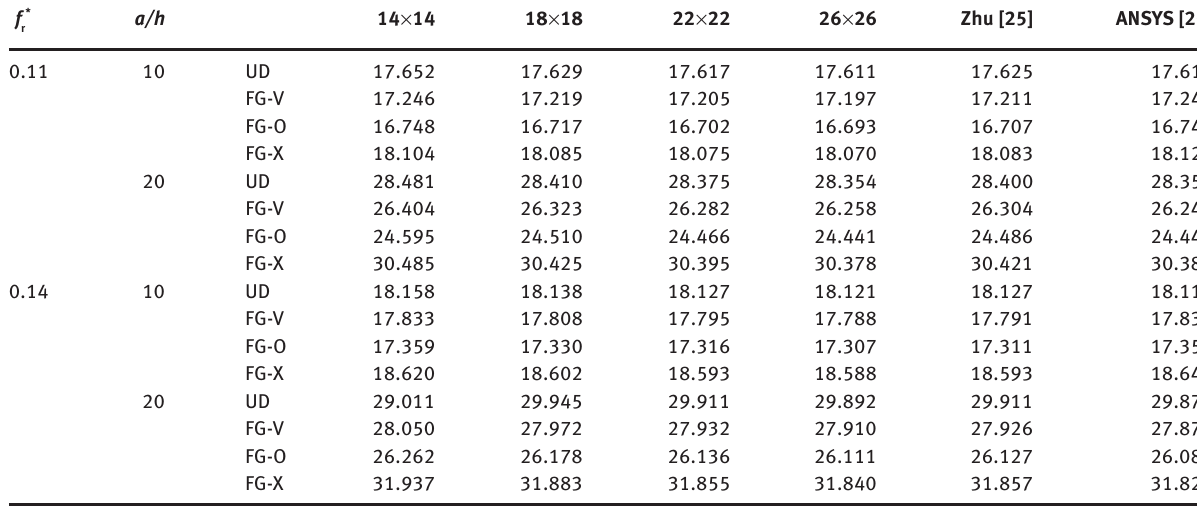
Table 6 Convergence and accuracy of the first dimensionless natural frequency